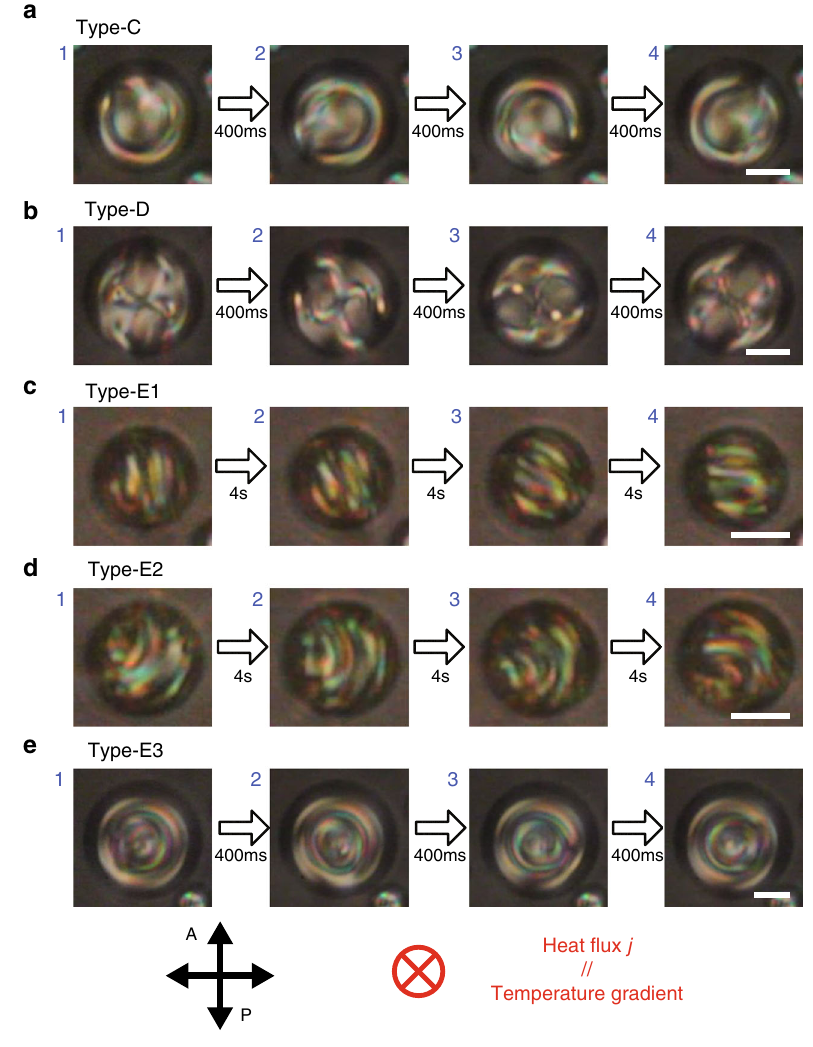
Fig. 4 Snapshots of HIR of the Ch droplets dispersed in the fl uorinated oligomer. HIR could be observed only in these fi ve types. Scale bars, 10 μ m. The time intervals between the snapshots for a Type-C, b Type-D and e Type-E3 are 400 ms and for c Type-E1 and d Type-E2 are 4 s. For all types, the temperature was stationary at 55 °C. The heat fl ux was applied in the viewing direction, as shown by the red cross symbol ( j = 6.0 mW mm − 2 for Type-C, Type-D and Type-E3, and j = 1.5 mW mm − 2 for Type-E1 and Type-E2). The concentration of the chiral dopant was 1.0 wt% for Type-C, Type-D and Type-E3 and 2.0 wt % for Type-E1 and